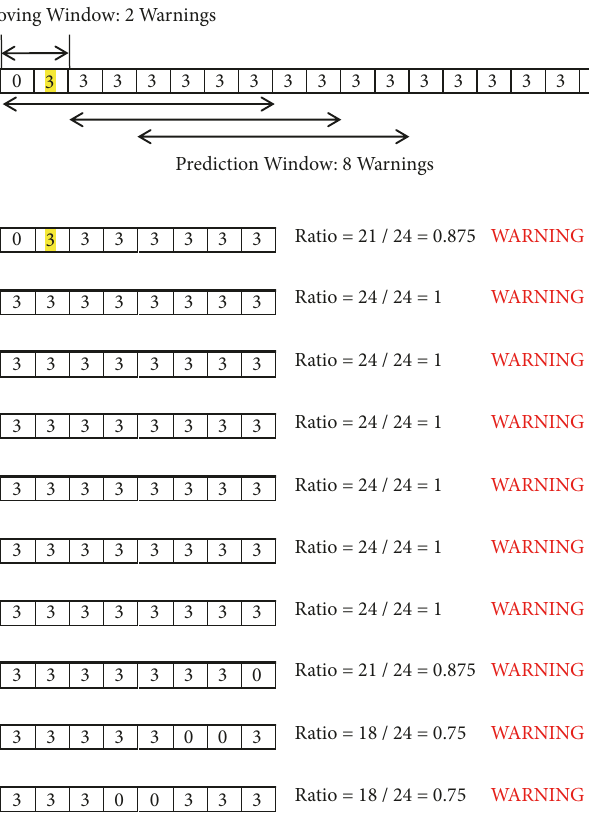
Figure 22: Prediction algorithm results for unhealthy subject